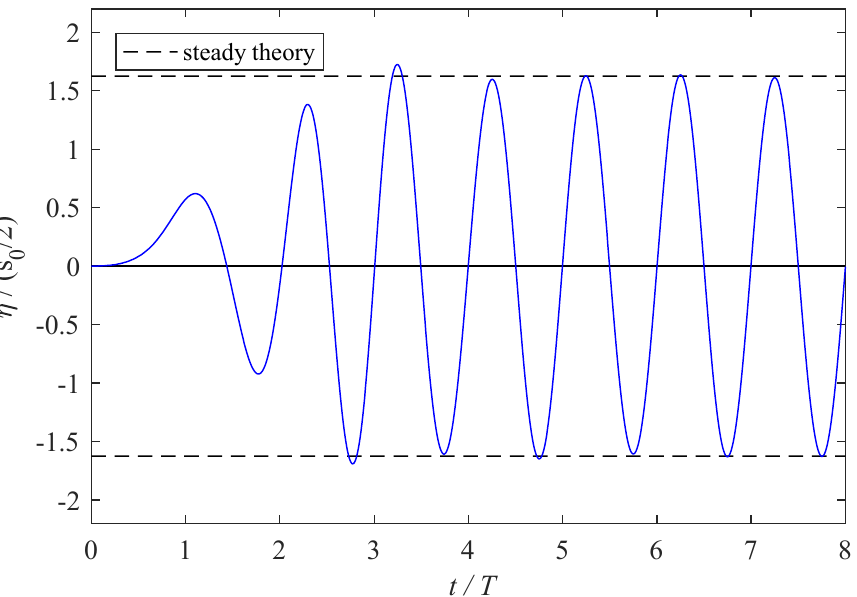
Figure 3. Surface evolution with time at a fixed location. ( T = 0.82 s, kh = 1.88). The distribution of surface wave along the channel at a fixed time after waves are generated is plotted in Figure 4. The horizontal axis is a dimensionless distance away from the wavemaker, and L 0 is the steady wave length. The vertical axis is the dimensionless surface elevation. The conditions used are h = 0.3 m, s 0 = 0.037 m, and T = 1.08 s,